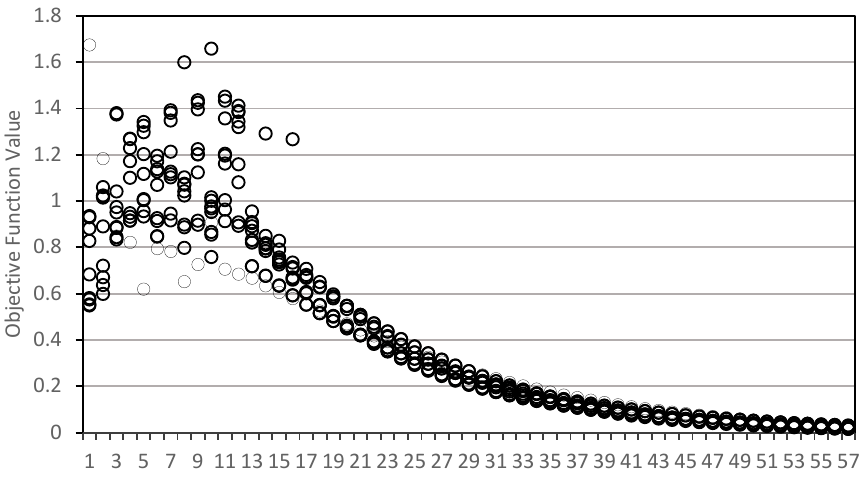
Figure 14. Objective function convergence trend for the optimal